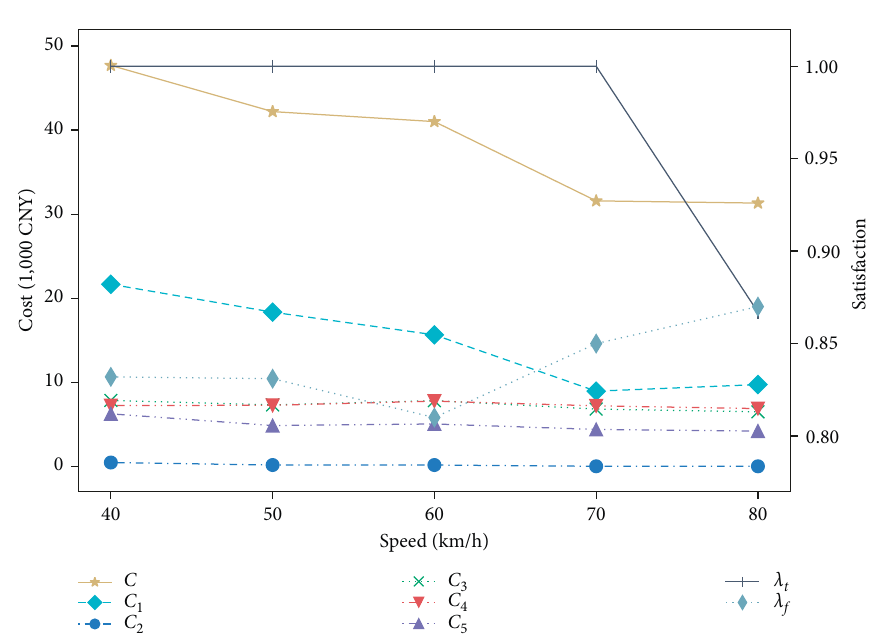
Figure 8: Cost and satisfaction of optimal paths with different railway transport speeds.